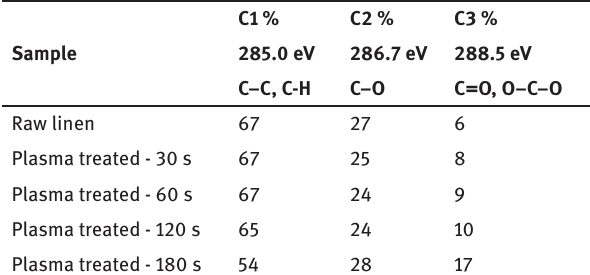
Figure 4: Oxygen-to-carbon ratio from XPS survey spectra (upper) and FT-IR ATR spectra (lower) for the linen samples as a function of time of air-plasma treatment. For FT-IR ATR spectra: a) 0 s (raw), b) 30 s, c) 60 s, d) 120 s, e) 180 s. Table 3: Results of decomposition of the C 1s peak for the surfaces of untreated and air-plasma treated linen as a function of time of plasma treatment.